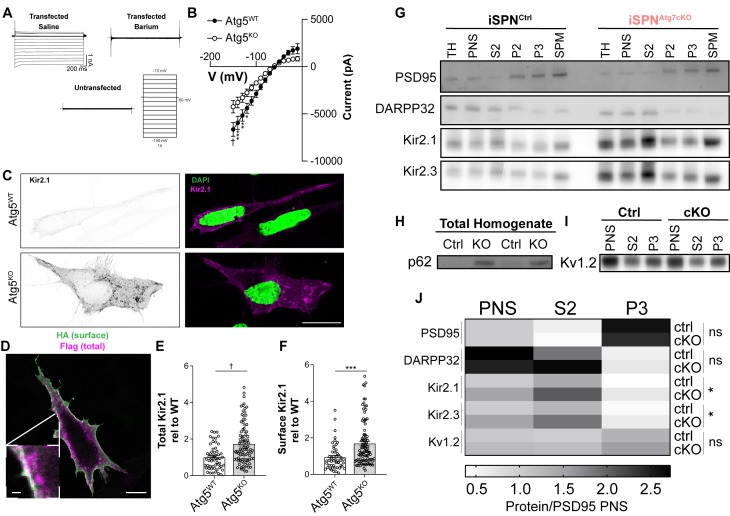
Autophagy is not required for Kir2 trafficking.(A) Sample traces from MEFs transfected with Kir2.1 demonstrate an inwardly rectifying, barium sensitive current that is absent in untransfected cells. (B) Atg5KO MEFs have reduced Kir2.1 current compared to Atg5WT MEFs. WT: N = 8, KO: N = 12. Voltage step x genotype: F(14, 252)=8.985, p<0.0001. (C) Representative micrographs of Atg5WT and Atg5KO MEFs. On right, the Kir2.1 channel in the WT image has been contrasted to compare staining pattern. Scale bar 20 µm. (D-F) Elevated levels of both surface and total levels of Kir2.1 in Atg5KO MEFs. Scale bar 20 µm, inset scale bar 1 µm. (E) t147=4.511, p<0.0001. (F) t147=4.511, p<0.0001. (G-J) Subcellular fractionation reveals elevated levels of Kir2.1 and Kir2.3 in all fractions of iSPNAtg7cKO mice compared to controls but no change in the relative distribution of Kir2.1 or Kir2.3 between genotypes. (H) p62 is elevated in the total homogenate of iSPNAtg7KO mice. (I) No change in distribution or level of Kv1.2 between genotypes. iSPNCtrl: N = 5. iSPNAtg7cKO: N = 3. TH, total homogenate; PNS, post-nuclear supernatant; S2, 20,000xg supernatant; P2, 20,000xg pellet; P3, resuspended P2 spun at 100,000xg; SPM, synaptic plasma membranes isolated from 1.0M and 1.2M sucrose interface. Data were analyzed by two-way ANOVA for each analyzed protein with fraction and genotype as factors. No significant interaction between fraction and genotype was found for any protein. Fraction was significant for each protein. Genotype was only significant for Kir2.1 and Kir2.3. Kir2.1: Genotype: F(1,6)=9.373, p = 0.0222. Kir2.3: Genotype: F(1,6)=6.615, p = 0.0422. See Table 1 for detailed statistics. ns p>0.05, *p<0.05, **p<0.01, ***p<0.001, † p<0.0001. Experiments in B, E, and F were combined from at least three independent experiments.Figure 7—source data 1.Source Data for Figure 7.